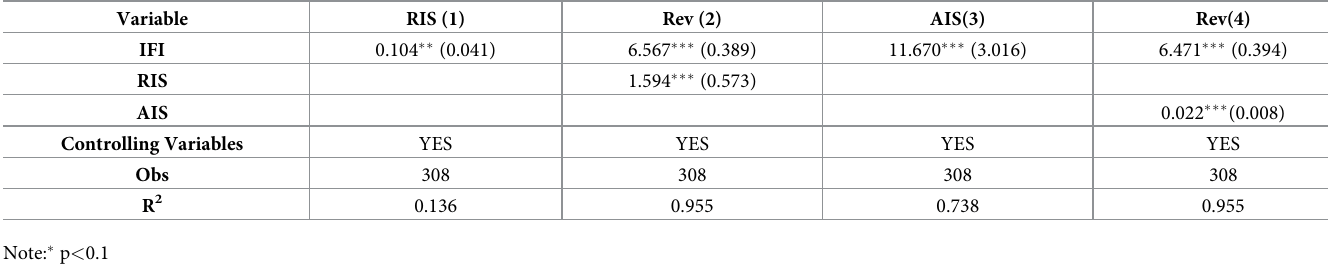
Table 9. Inclusive finance and farmers’ income: Mechanism